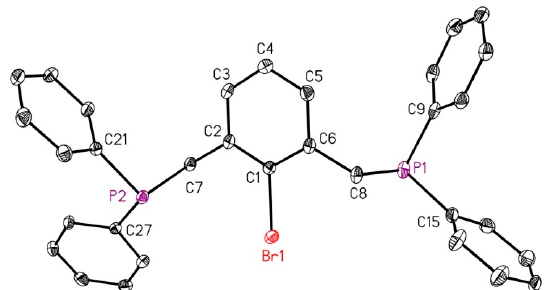
Figure 2. Molecular structure and atom numbering scheme of bromo-2,6-bis(diphenylphosphanyl methyl)benzene ( 1a ). The ellipsoids represent a probability of 30%; H atoms are shown with arbitrary